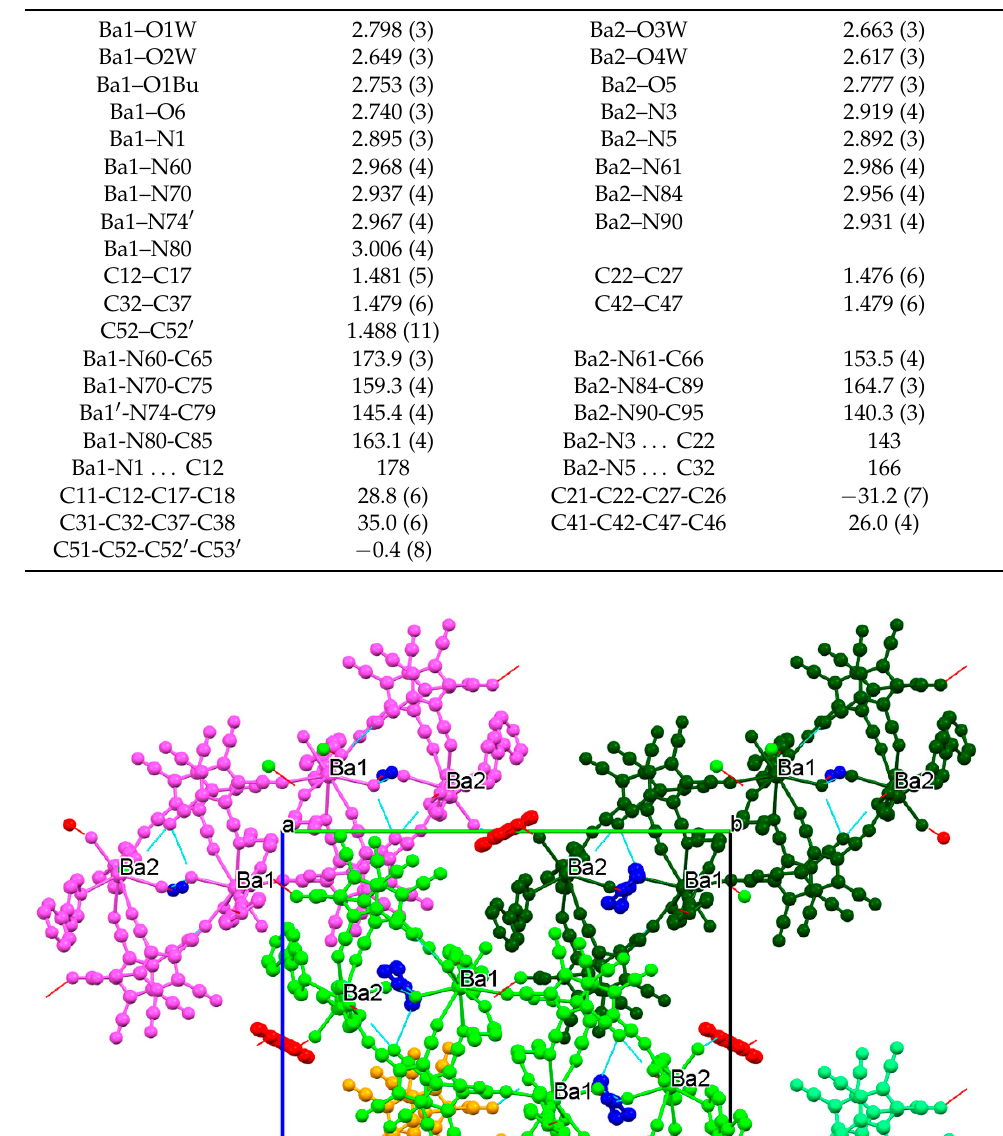
Table 4. Important bond parameters [Å, ◦ ] of compound 6 .